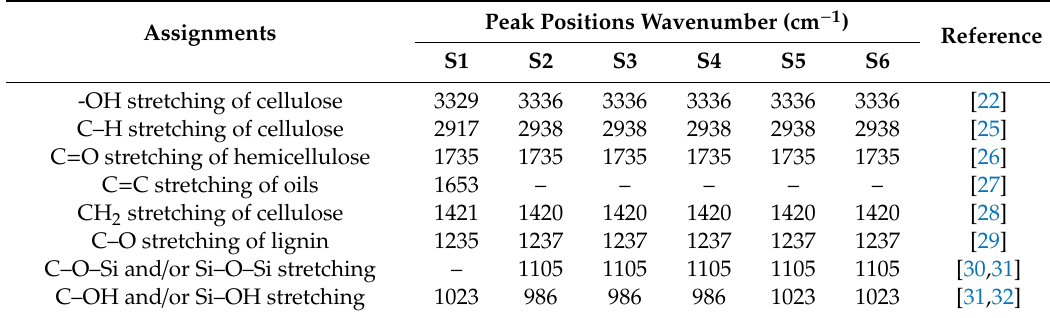
Figure 4. ( a ) X-ray Diffractometry (XRD) analysis and ( b ) crystallinity index (CI) and crystallite size (CS) of unmodified and modified jute fabrics.